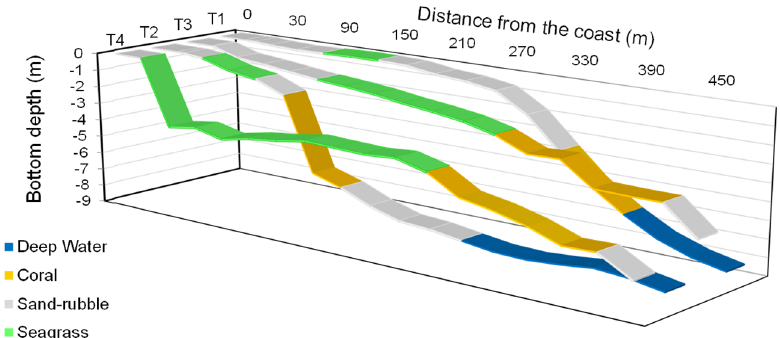
Figure 6. Depth profiles of four transects ( cf. Figure 5) with relative bottom cover classes. Transects start from the coastline and extend for about 400 m. All transects have been selected in correspondence of bays where also mangrove forests have been detected.